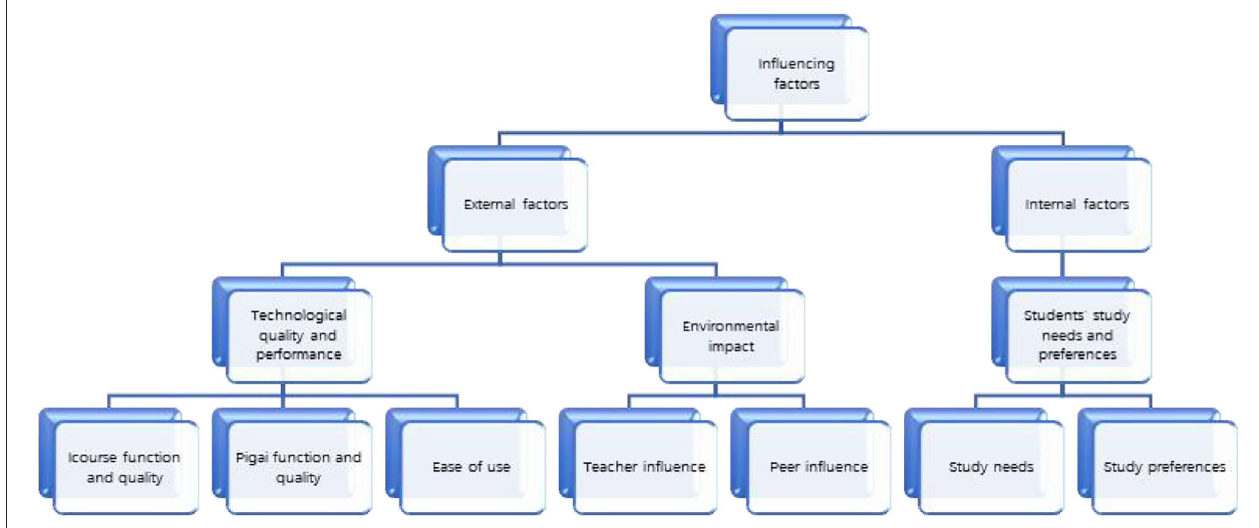
FIGURE 9 | Technology use factors toward technology-supported SRL.